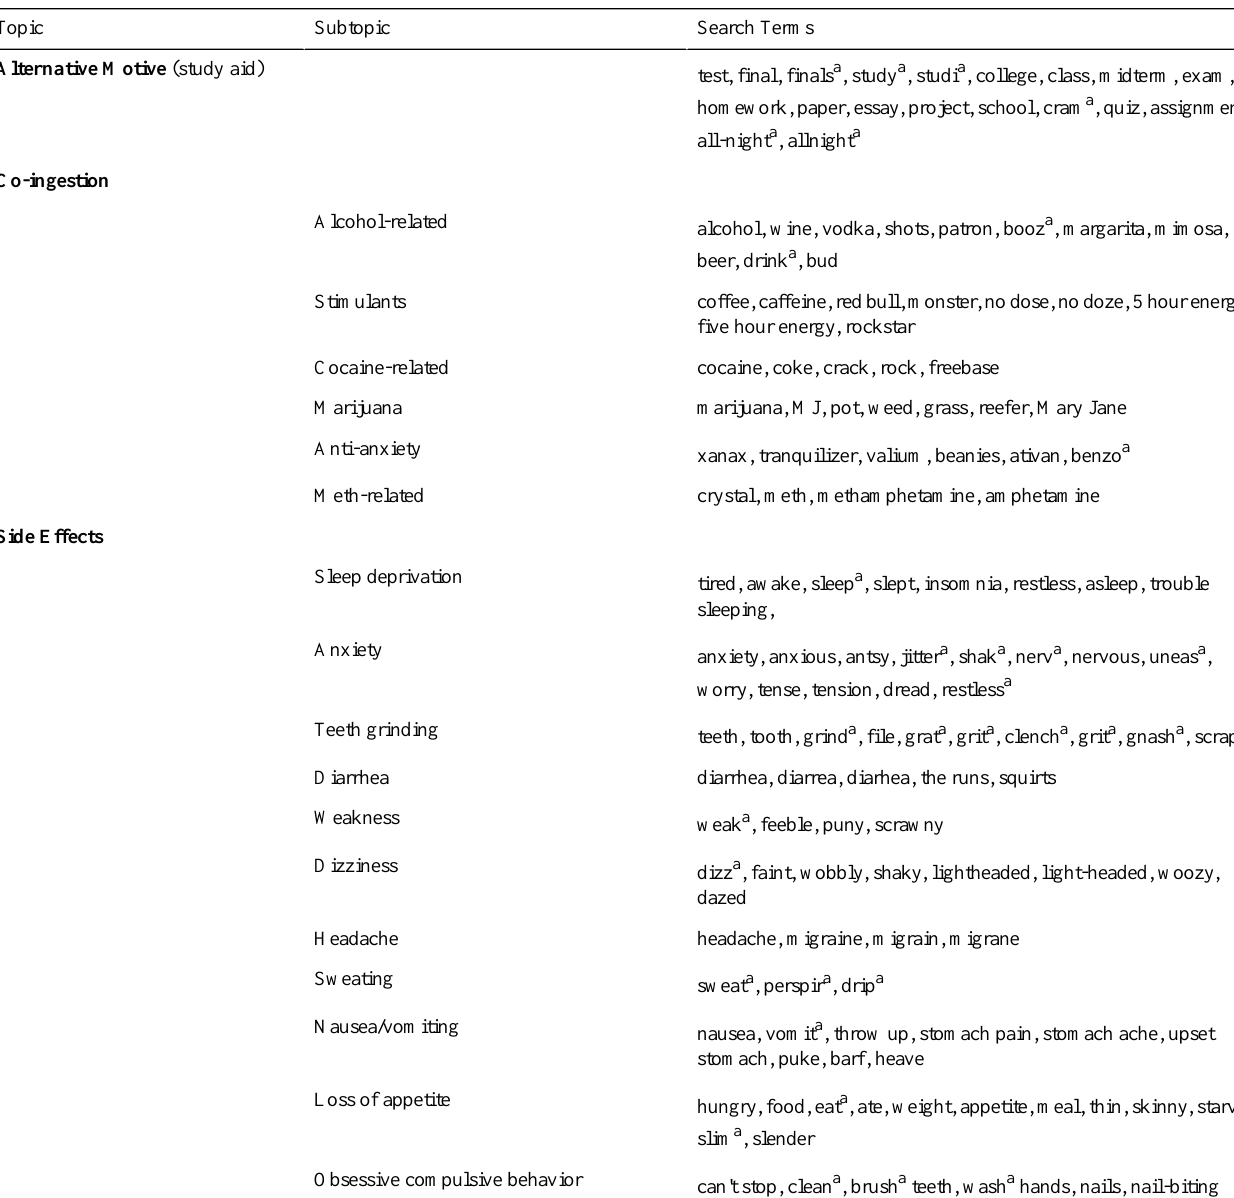
Table 1. Search terms for alternative motive, co-ingestion, and side effects.